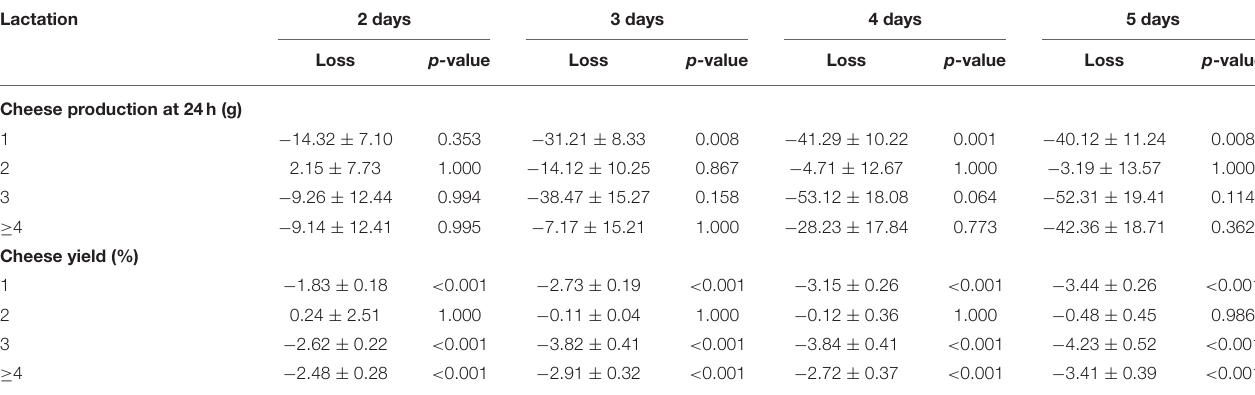
TABLE 5 | Relative variation of cheese production at 24h (g), cheese yield (%) after heat waves lasting 2, 3, 4, and 5 consecutive days, in comparison with the losses estimated after a single day of daily maximum THI over the threshold, for the different parity classes. Lactation 2 days 3 days p- value Loss p- value Cheese production at 24h